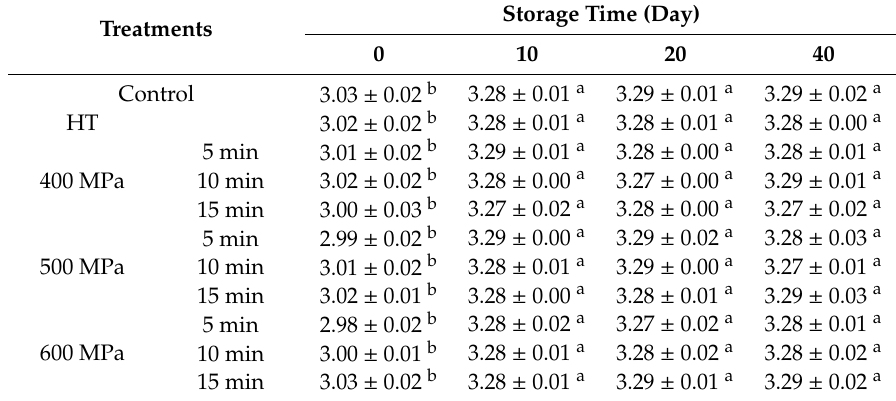
Table 1. Changes in pH of heat-treated and high hydrostatic pressure (HHP)-treated kiwifruit pulp beverage during storage at 4 ◦ C for 40 days.